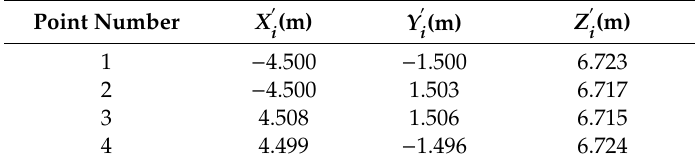
Table 3. Coordinates of controlled points in the external coordinate